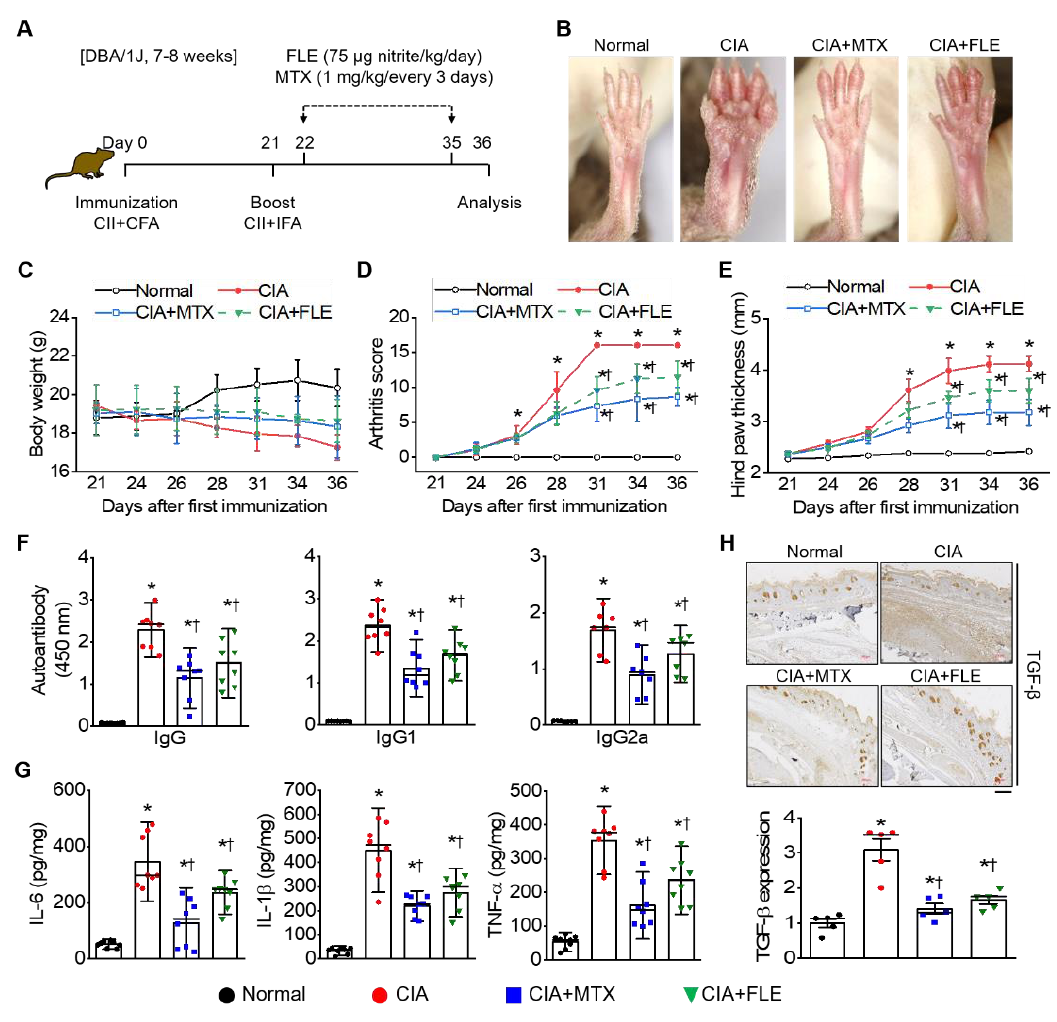
Figure 1. Fermented lettuce extract (FLE) attenuated RA symptoms in collagen-induced arthritis (CIA) mice. ( A ) Timeline of animal experiments. CIA DBA/1J mice were immunized with tail-vein injections of type II collagen. One group was orally administered FLE daily from days 22 to 35. Standard RA drug MTX was injected intraperitoneally once every 3 days as a positive control. ( B ) Representative photographs of hind paws, showing swelling and ankylosis in immunized mice. Body weight ( C ), arthritis score ( D ), and hind-paw thickness ( E ) were measured every 2 days during FLE administration. On day 36, serum levels of IgG, IgG1, IgG2a ( F ), and inflammatory cytokines IL-6, IL-1 β , and TNF- α ( G ) were confirmed via ELISA. ( H ) Immunohistochemistry of TGF- β expression. Scale bar represents 200 µ m. Data are shown as means ± SE ( n = 8). * p < 0.05, compared to Normal. † p < 0.05, compared to CIA.